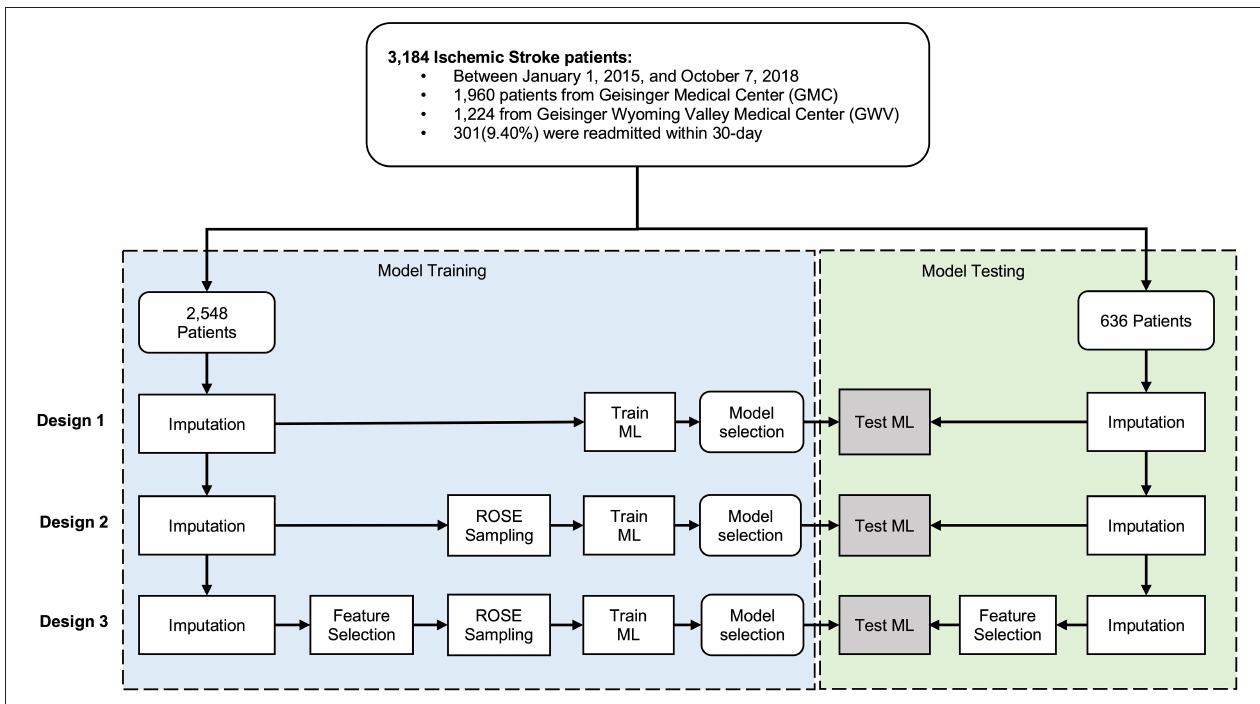
FIGURE 1 | Data processing